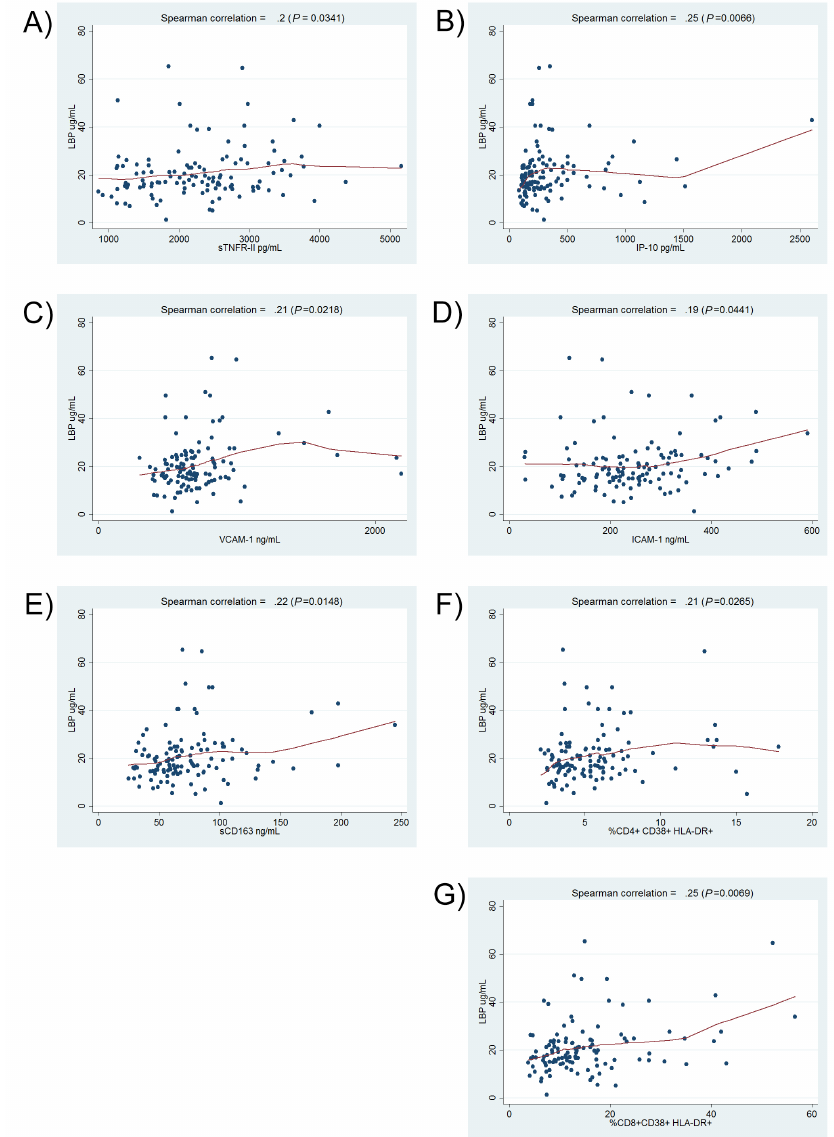
Figure 1. Plasma levels of lipopolysaccharide binding protein (LBP) are related to markers of immune activation in HIV-infected patients. Plasma samples were thawed and levels of (A) TNFr-II, (B) IP-10, (C) VCAM-1, (D) ICAM-1, and (E) sCD163 were measured by ELISA. Measurement of T-cell activation was performed by flow cytometry to assess surface activation markers (CD38, HLA-DR) on cryopreserved (F) CD4+ and (G) CD8+ T cells. Correlations between markers at baseline were determined using Spear- man rank correlation, and lines were fitted to the data points using locally weighted regression